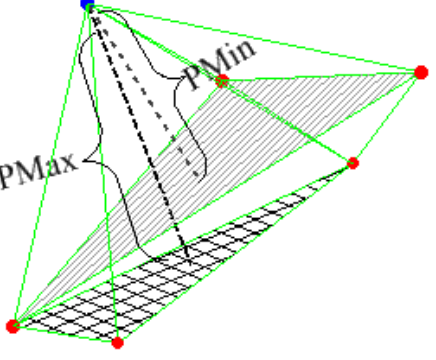
Figure 7. Minimum and maximum plan